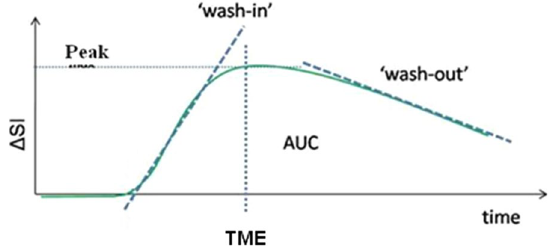
Fig. 5 Signal intensity curve over